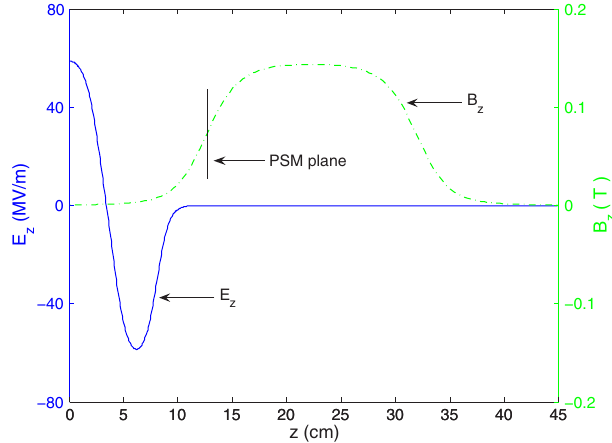
FIG. 4. (Color) Electric field distribution and the magnetic field distribution. The horizontal axis represents the distance from the